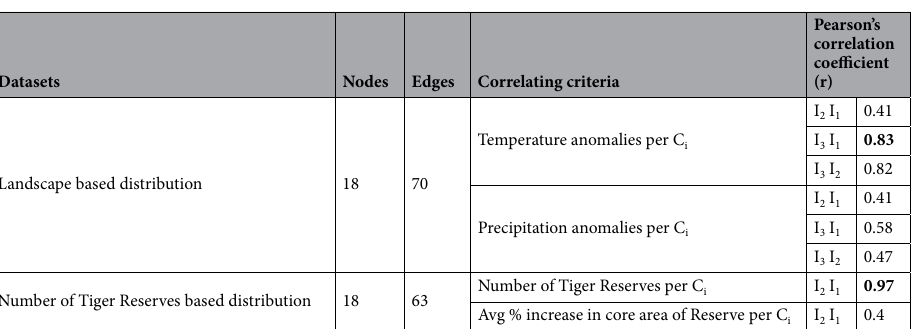
Table 3. Statistical validation of the correlation between land-use conversion, climate change and biodiversity change for Landscape based dataset and Number of Tiger reserves based dataset.